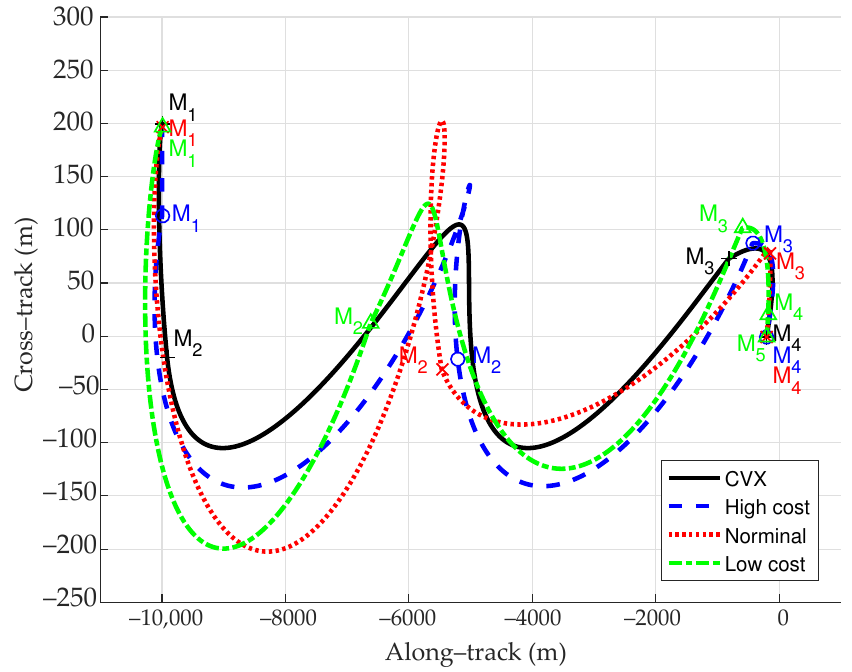
Figure 11. Optimal trajectories (out-of-plane) when t f = 12,000 s.